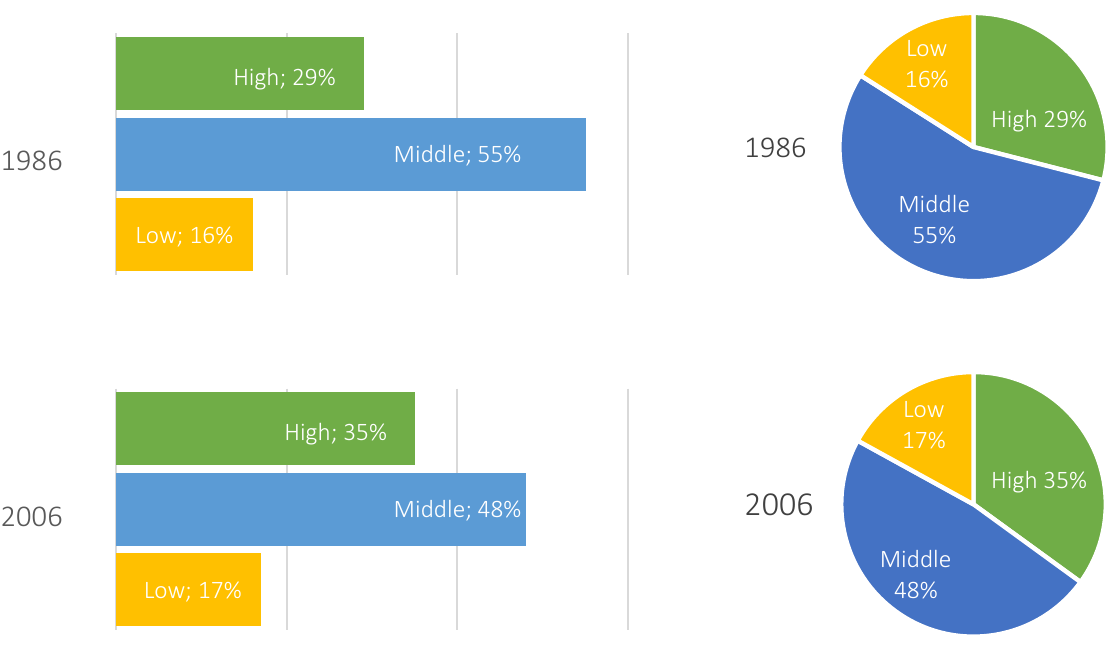
Figure 11. Employment shares by occupational skill level, 1986 and